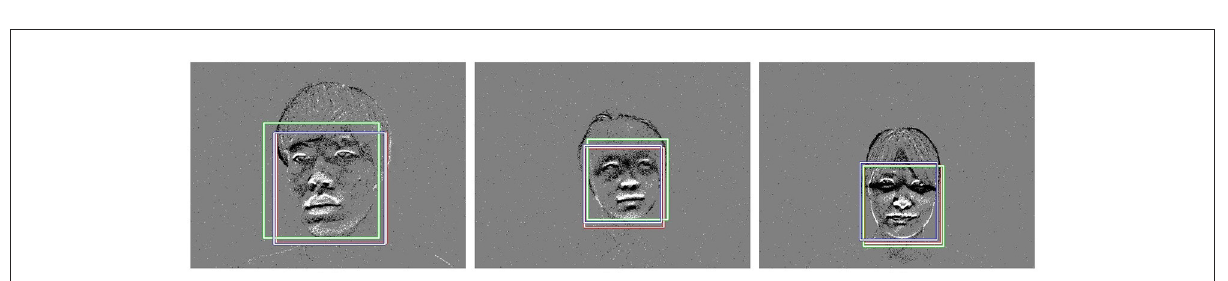
FIGURE7 Face detection results (red: ground truth, green: model by frame-based image, blue: model by event image).